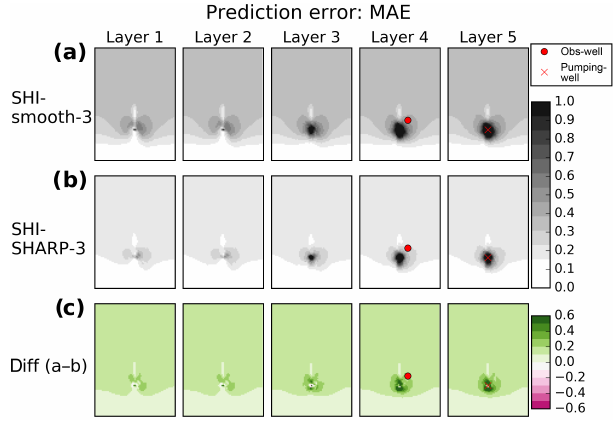
Figure 10. MAE contour map for head recovery prediction. (a) For predictions using the SHI-smooth models. (b) For predictions using the SHI-smooth models. (c) Difference between the maps shown in (a) and (b) . Red dots mark the location of the observation well for the head recovery prediction shown in Fig. 9. The red cross marks the location of the pumping